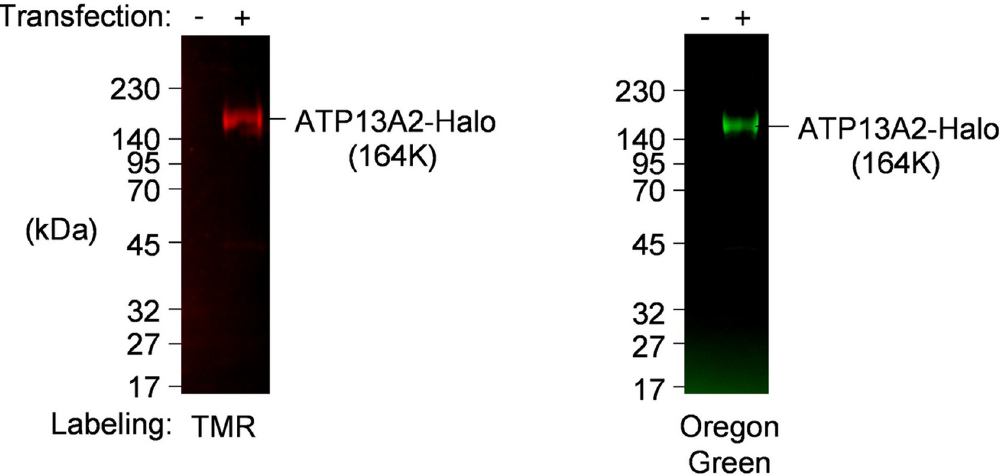
Fig 1. Construction and expression of ATP13A2-Halo. Halo tag was C-terminally fused with human ATP13A2. Pilot expression in HEK cells produced expected size of ATP13A2-Halo protein (164K). Stable cells were harvested and microsomes were prepared. ATP13A2-Halo was specifically labeled ex vivo with TMR-ligand (left) or Oregon green (right), followed by SDS-PAGE and fluorescence imaging.